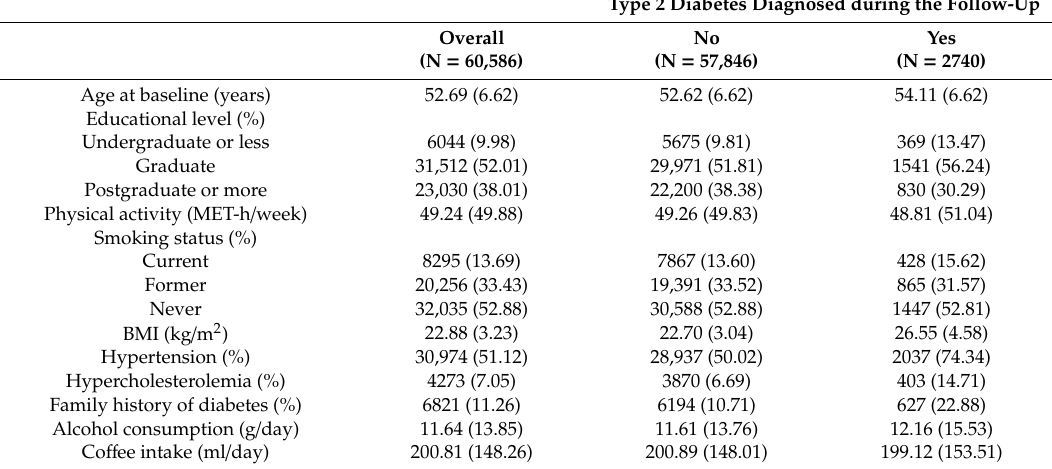
Table 1. Baseline characteristics of the Etude Epid é miologique aupr è s de femmes de l’Education Nationale (E3N) study population overall and by diabetes